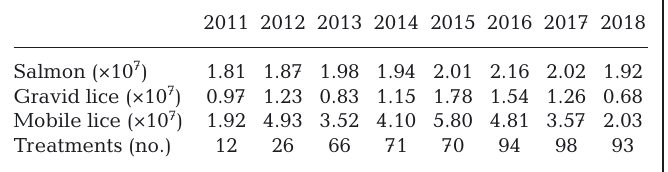
Table 2. Number of salmon and treatments per year, and average num-